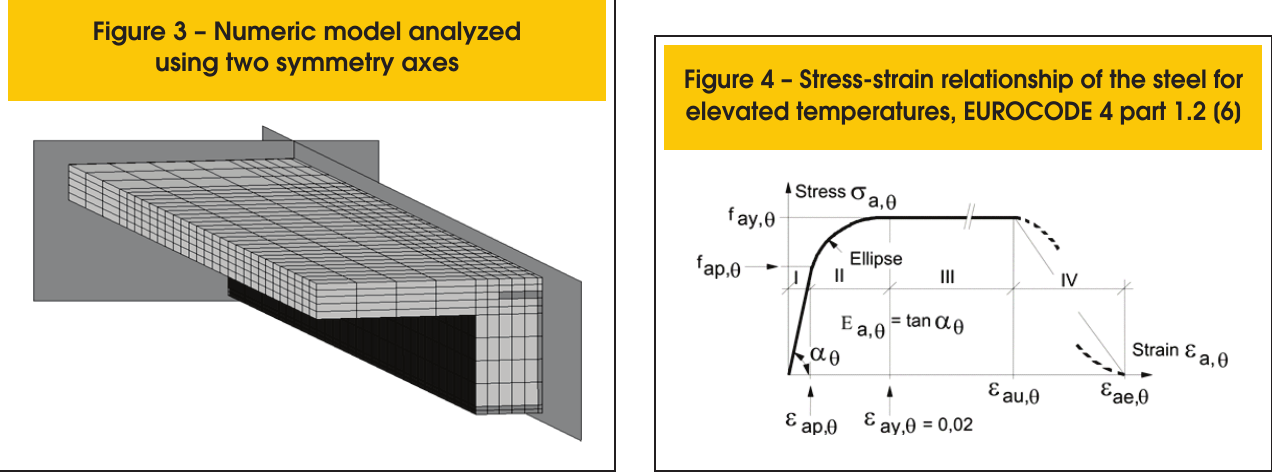
Figure 3 – Numeric model analyzed using two symmetry axes